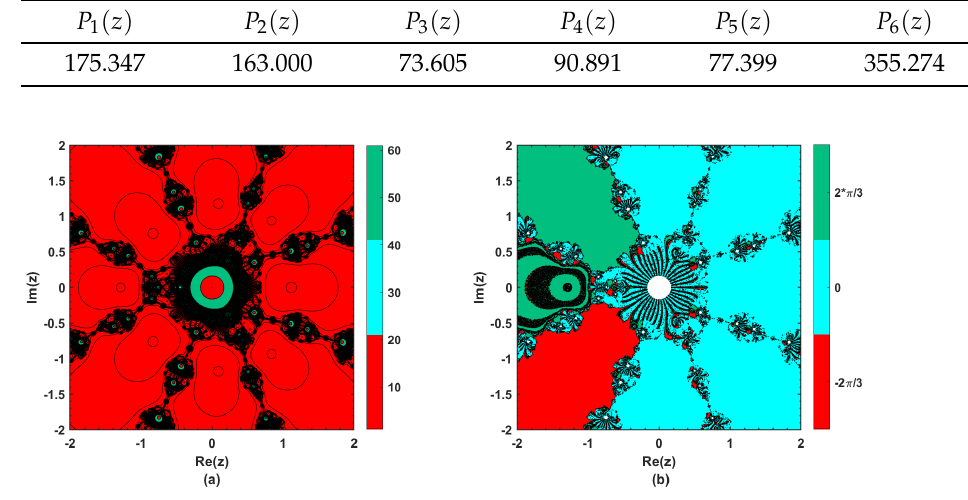
Figure 1. The polynomiographs obtained by the proposed method PS9 for P 1 ( z ) .